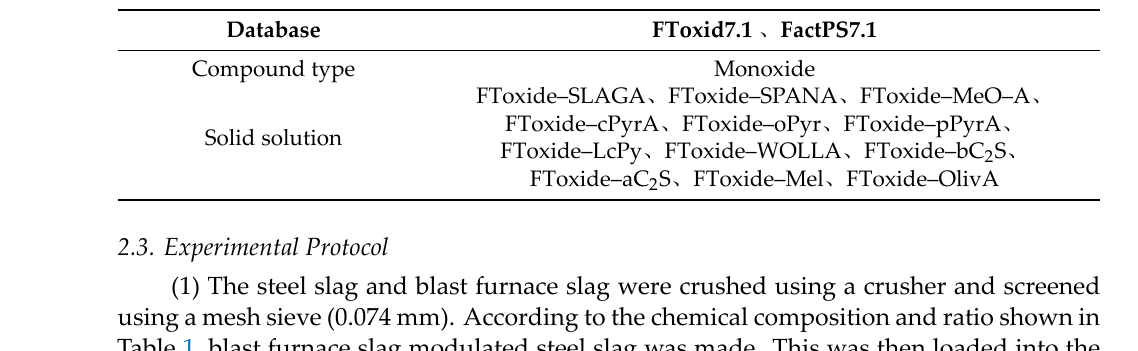
Table 2. Parameters setting of